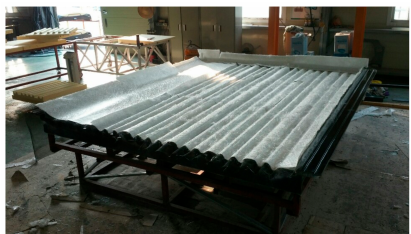
Figure 15. Lay-up glass fiber on mold.